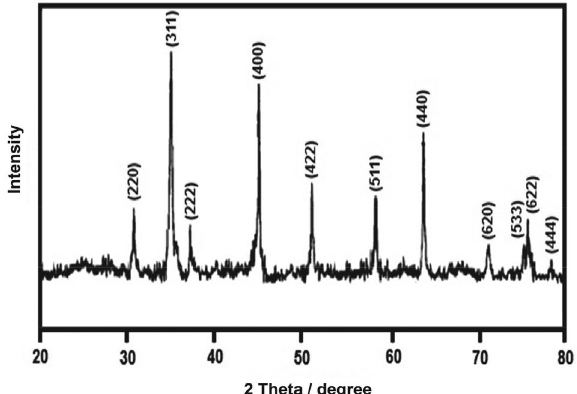
Fig. 2. X-ray diffraction patterns of the NiFe 2 O 4 nanoparticles.